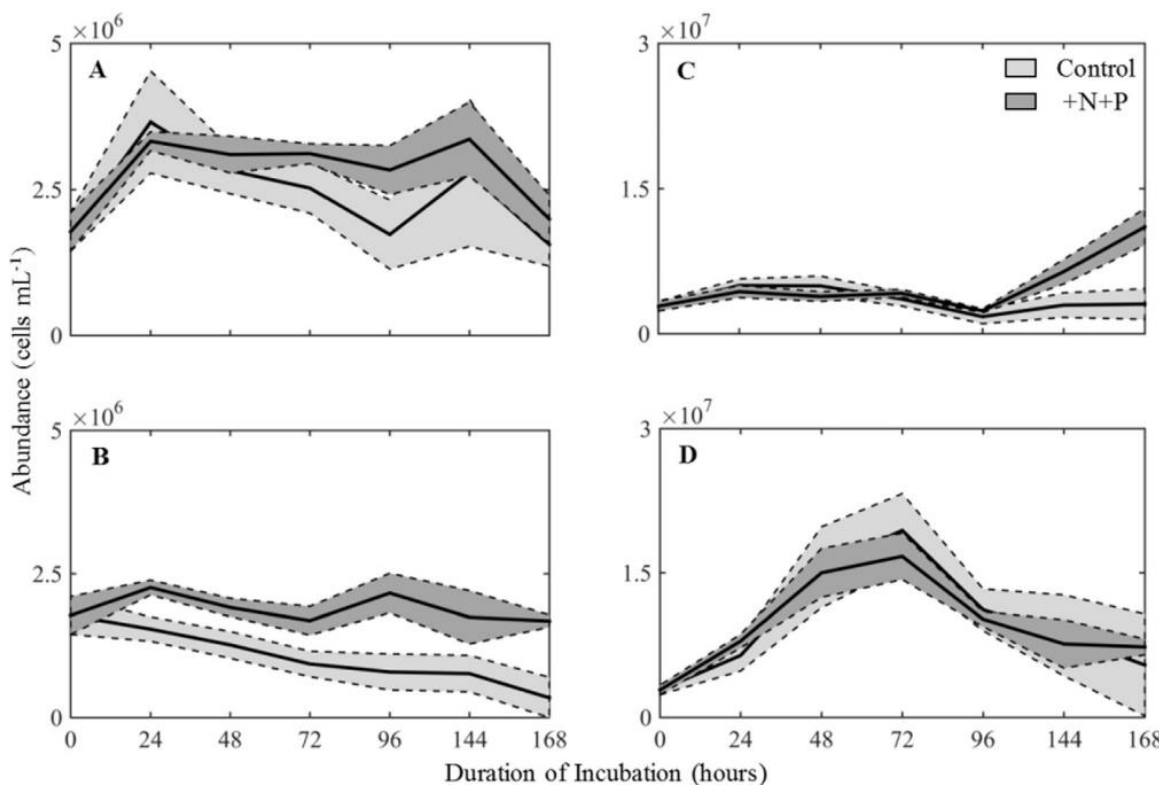
Figure 4. Comparing the microbial plankton abundance in incubated treatments over a total of 168 h, without nutrient enrichment (control) and with nitrogen and phosphorus (+N, +P). The black line is the mean value while the shaded represents standard deviation among the three replicates. The concentrations of autotrophic cells are illustrated in ( A ) for Station 2 and ( B ) for Station 3. As well, the concentrations of heterotrophic cells at Station 2 and Station 3 are illustrated in ( C , D ), respectively. Adapted from Williams et al. [31].